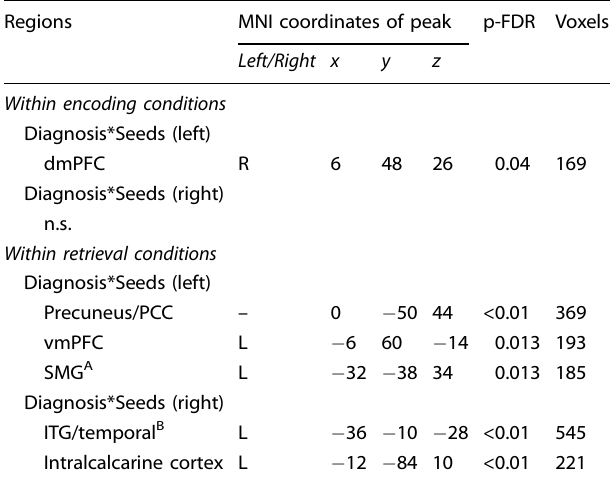
Table 2. Brain regions demonstrating signi fi cant connectivity patterns between anterior and posterior Hippocampus in patients versus healthy controls.